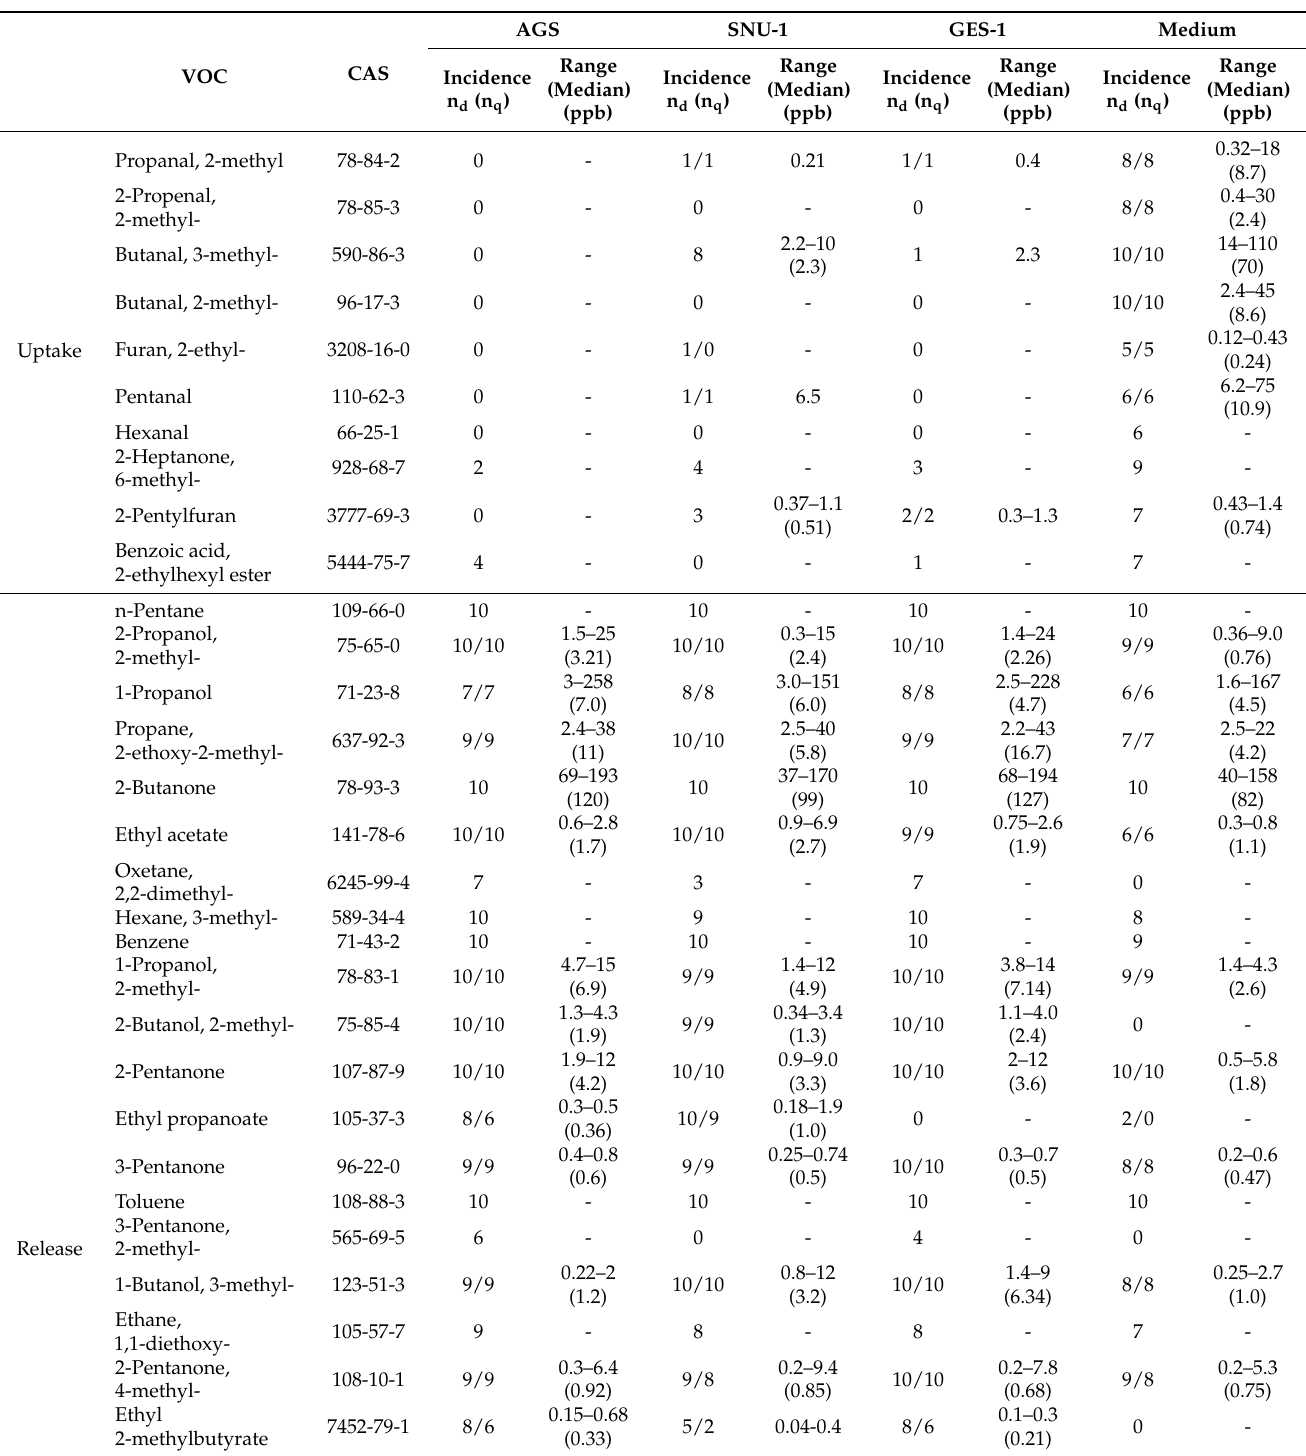
Table 3. Detection (n d ) and quantification (n q ) incidences, concentration ranges, and medians (for calibrated compounds) of VOCs in the headspace of media and cell cultures. Compounds are ordered with respect to increasing retention time. Compounds in italics were not quantified for reasons mentioned in the